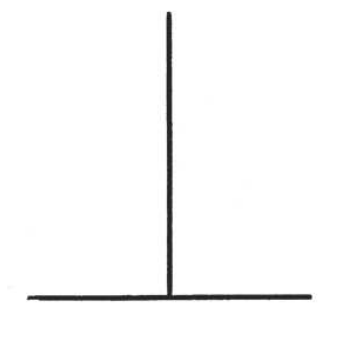
Fig. 5. The horizontal- -vertical illusion. Source: Adapted from Dere- gowski,